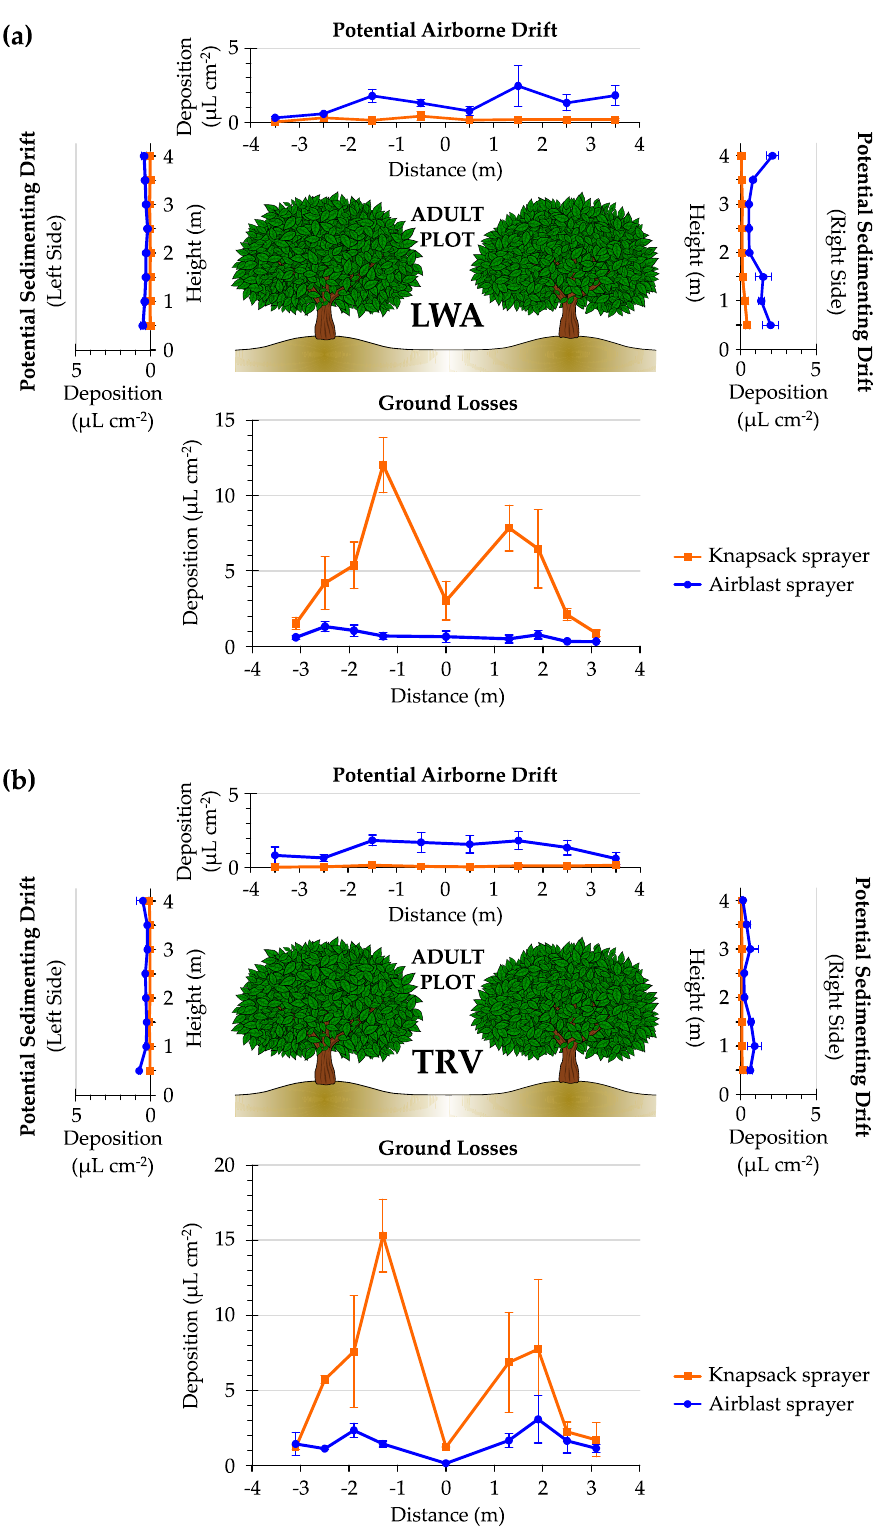
Figure A3. Off-target losses (mean (s.e.), μ L cm − 2 ) with the knapsack and the air-blast sprayer in the Figure A3. O ff -target losses (mean (s.e.), µ L cm − 2 ) with the knapsack and the air-blast sprayer in the adult plot and with dose expression using ( a ) LWA and ( b ) TRV. adult plot and with dose expression using ( a ) LWA and ( b )